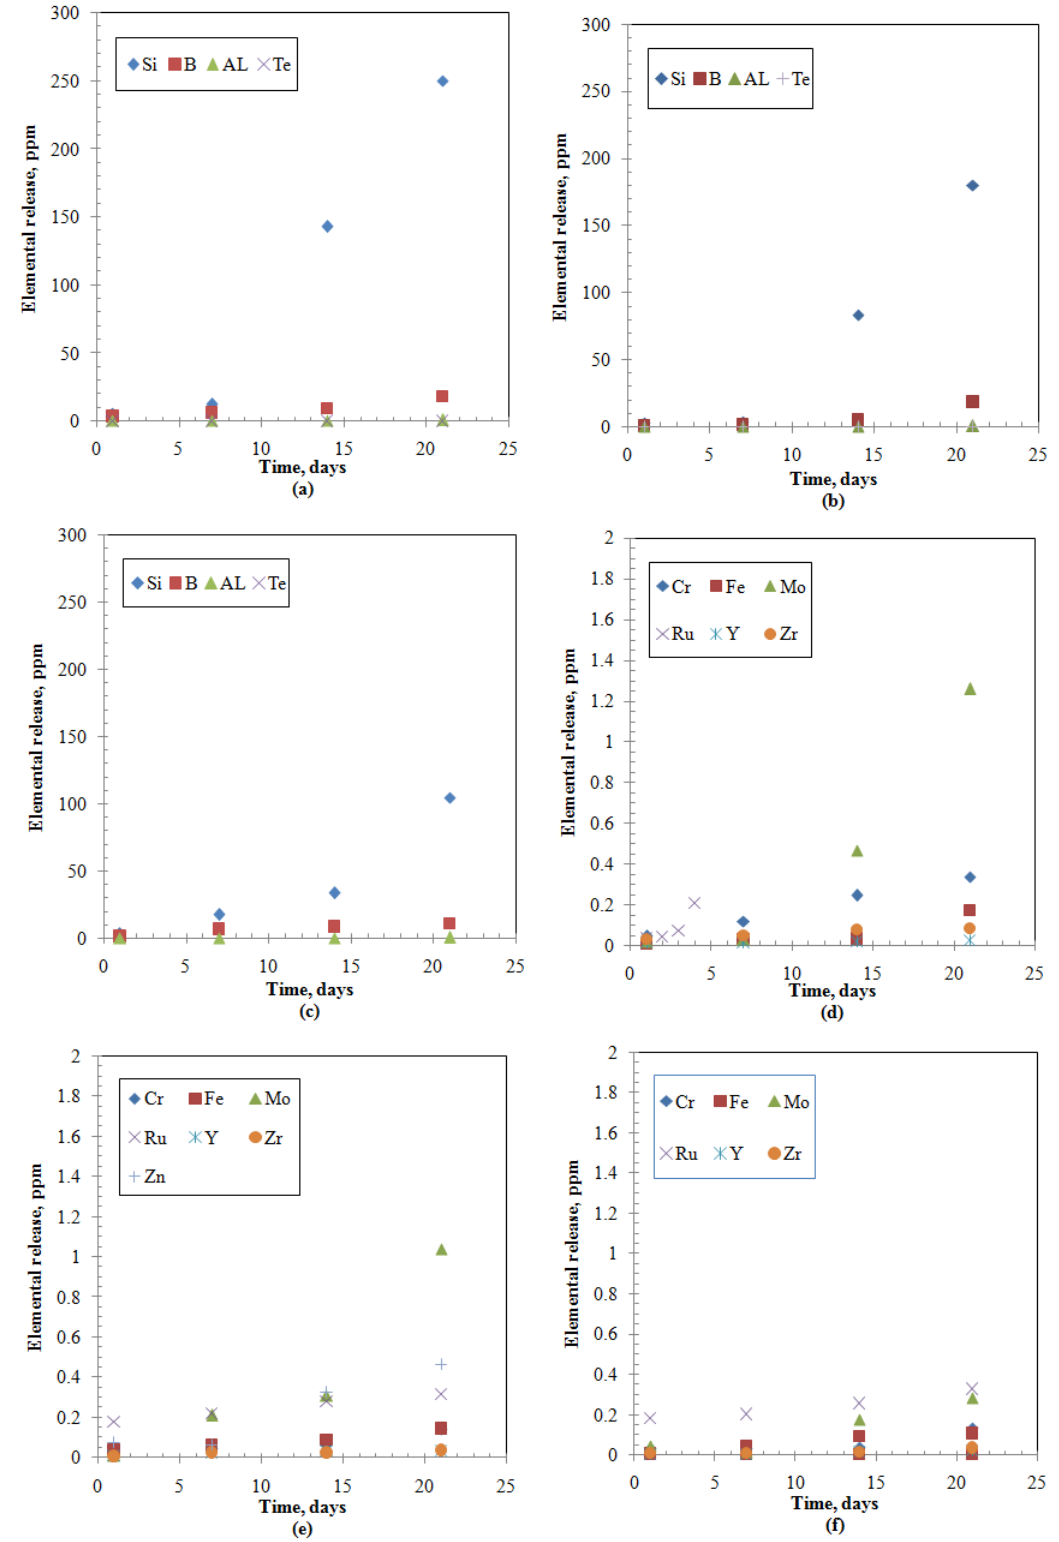
Figure 2. Elemental releases from the studied samples: ( a ) Metalloid and post-transition-ABS-Waste (17); ( b ) Metalloid and post-transition-MABS-Waste (20); ( c ) Metalloid and post-transition-ABS-Waste (25); ( d ) Transition-ABS-Waste (17); ( e ) Transition-MABS-Waste (20); ( f ) Transition-ABS-Waste (25).